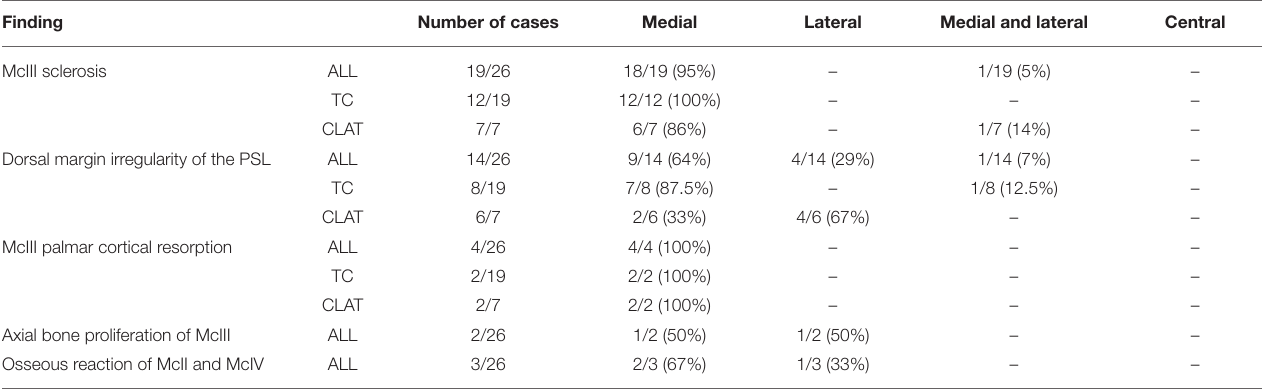
TABLE 4 | Distribution of pathological findings in control limbs.